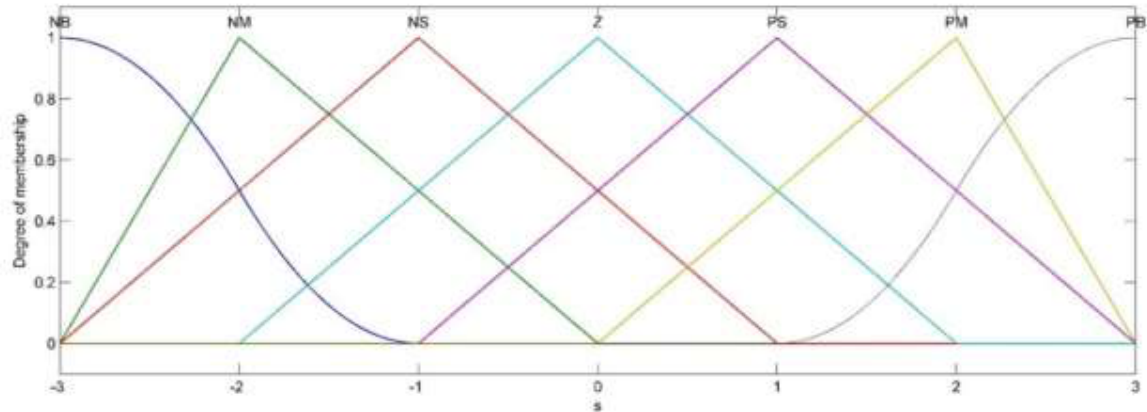
Figure 4. The membership functions of the input